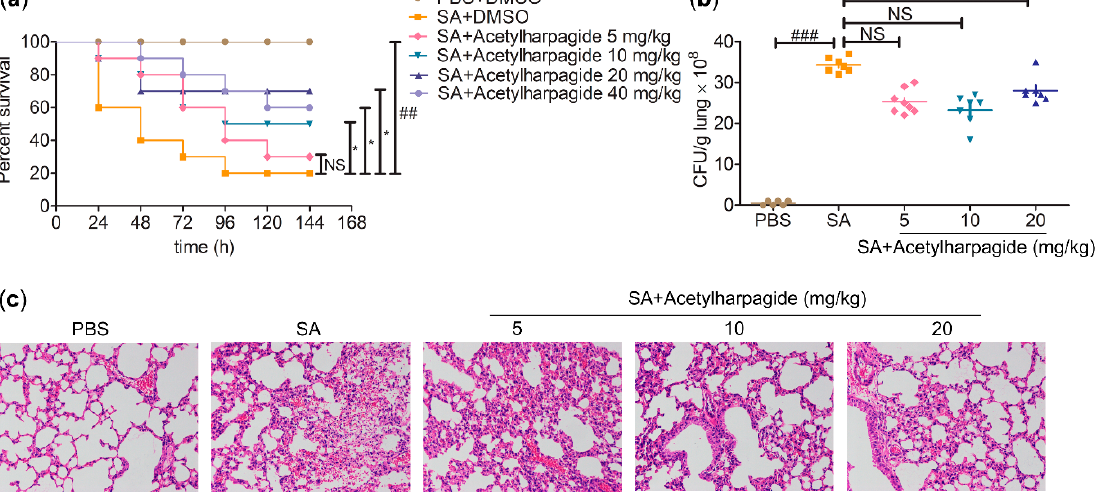
Figure 2. Acetylharpagide protected mice from Staphylococcus aureus (SA)-induced acute lung injury (ALI). ( a ) Acetylharpagide was injected intraperitoneally daily from day 0 to 5. The survival of S. aureus -infected mice with or without acetylharpagide was recorded. Kaplan-meier curves and log rank test were used to compare mortality rates, ## p < 0.01 vs. phosphate bu ff ered saline (PBS) + DMSO group, * p < 0.05 vs. SA + DMSO group, n = 10; ( b ) The bacterial loads of the lung homogenate were measured at 12 h after S. aureus infection. The data were presented as mean ± SD, ### p < 0.001 vs. PBS + DMSO group, n = 6–8; ( c ) Hematoxylin and eosin staining of mouse lung tissues that infected with S. aureus for 12 h, × 200.